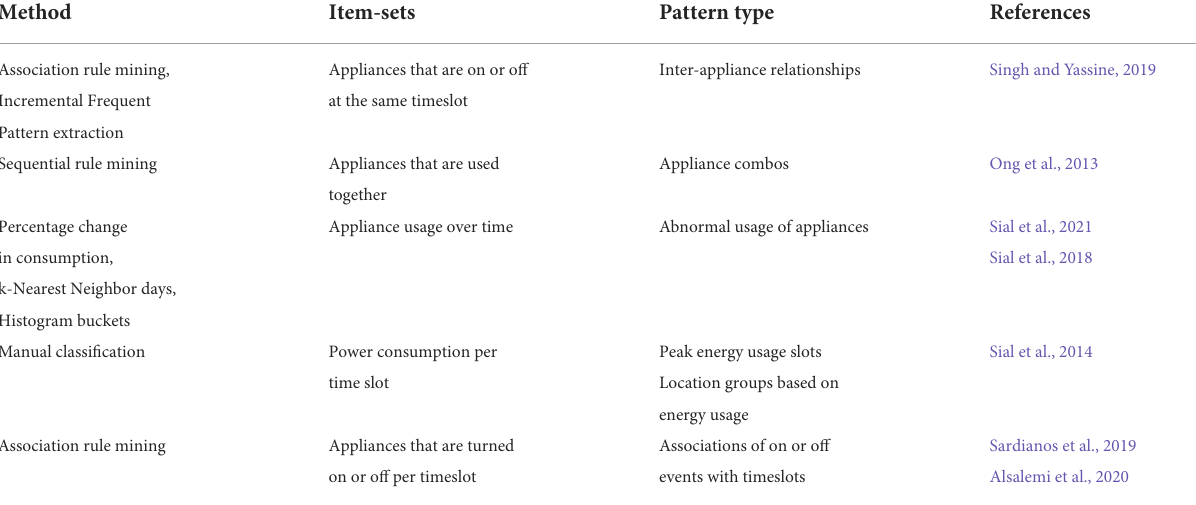
TABLE 1 Pattern extraction methods from energy usage